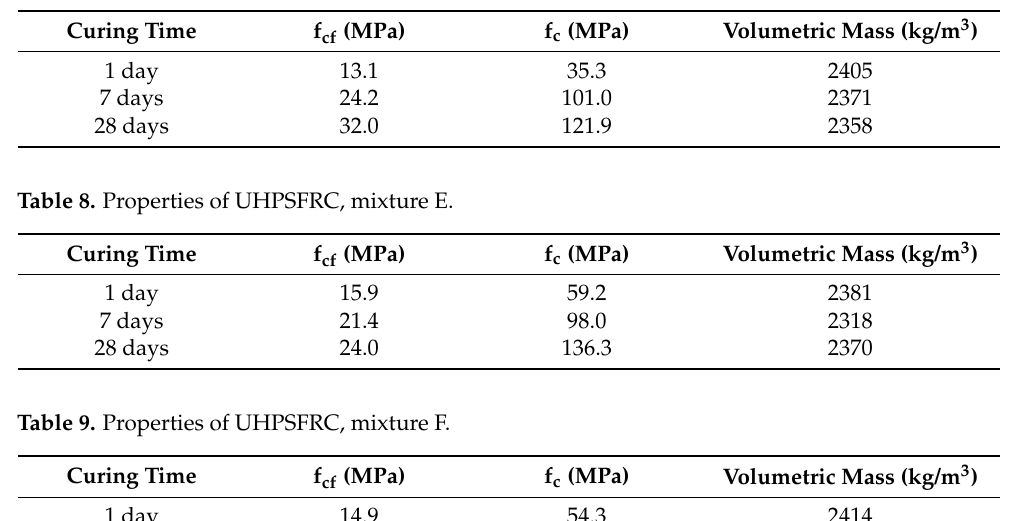
Table 7. Properties of UHPSFRC, mixture D.